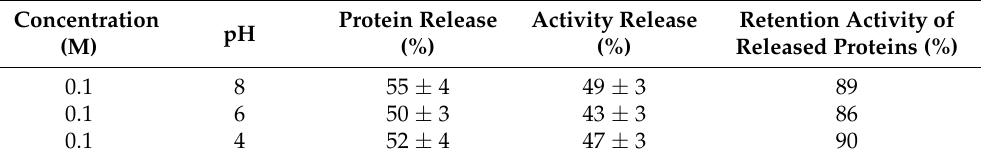
Table 7. Cutinase release and residual activity in sodium phosphate buffer 0.1 M at different pH, after 4 h. The retained activity is calculated with respect to the protein released.